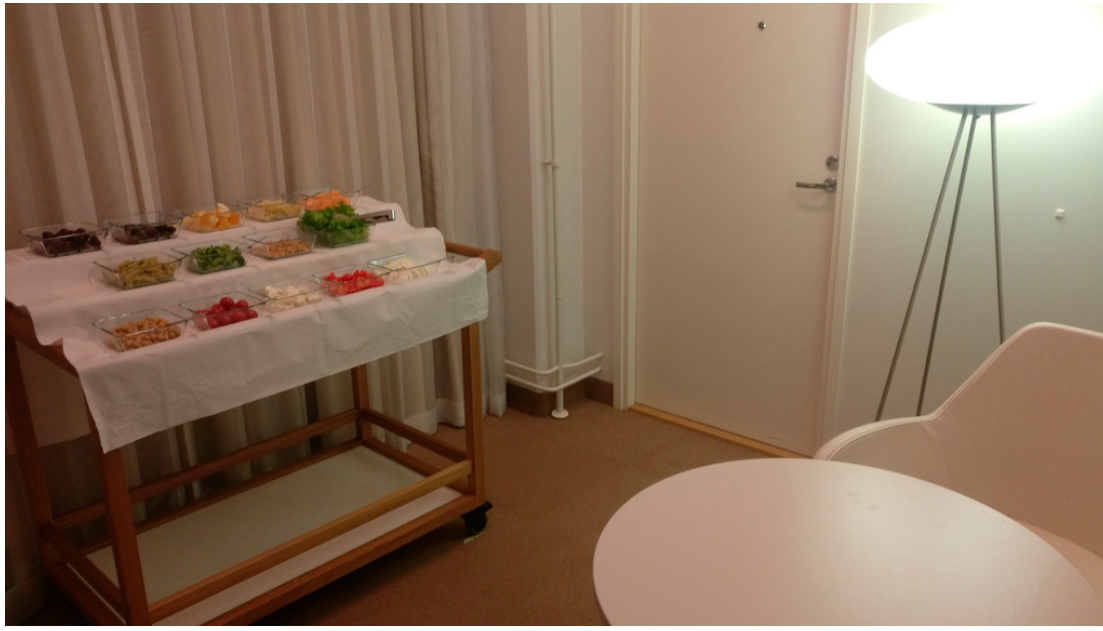
Figure 1. Serving trolley with the buffet foods.